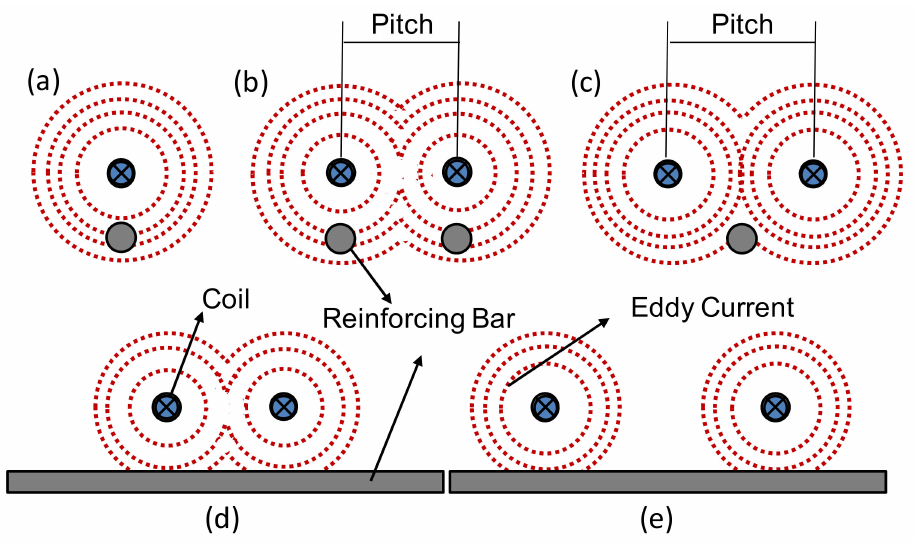
Figure 14. Relationship between work (reinforcing bar) and heating coil combination